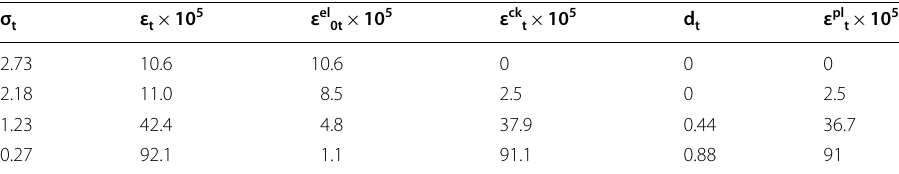
Table 4 Values of other parameters for concrete tension stiffening σ